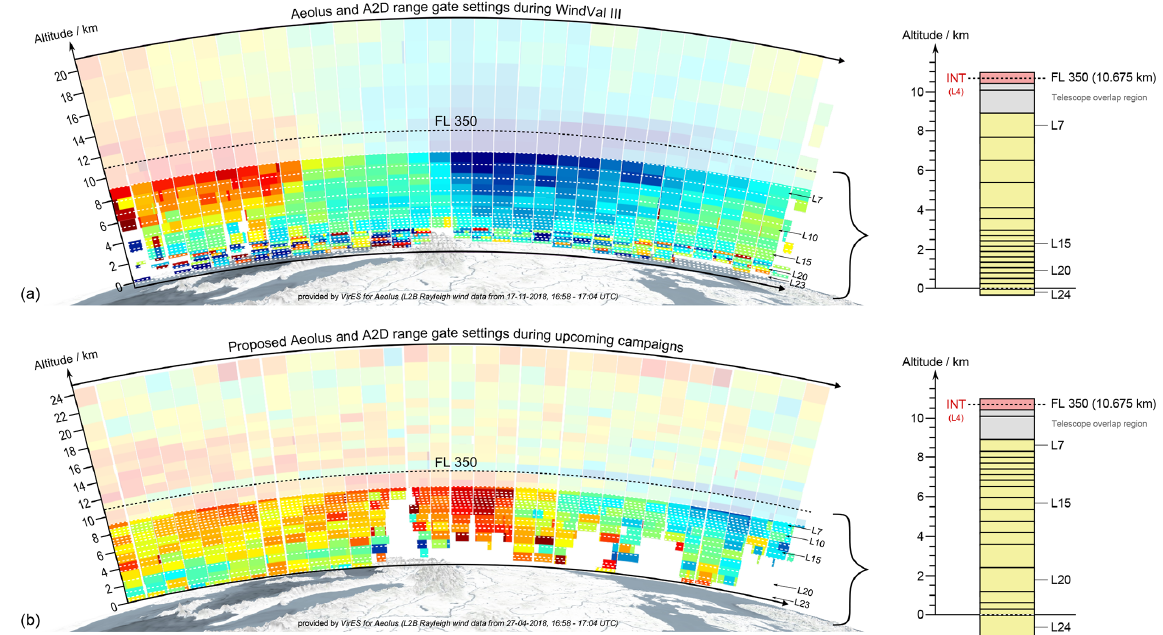
Figure 14. Diagram illustrating (a) the A2D range gate setting used during the WindVal III campaign and (b) an optimized range gate setting planned to be used in forthcoming airborne validation campaigns. The left part of the figure shows exemplary Aeolus L2B Rayleigh wind curtains with indicated bin altitudes of the A2D range gates (white dashed lines) assuming a flight altitude of about 10675m (FL 350). The corresponding vertical range gates (atmospheric layers; L) are also depicted on the right. Due to the incomplete telescope overlap, the wind data from the first 1.5km below the aircraft show increased wind errors and are consequently not used. The figure was created based on screenshots from the Aeolus data visualization tool, © VirES for Aeolus (https://aeolus.services/, last access: 12 November